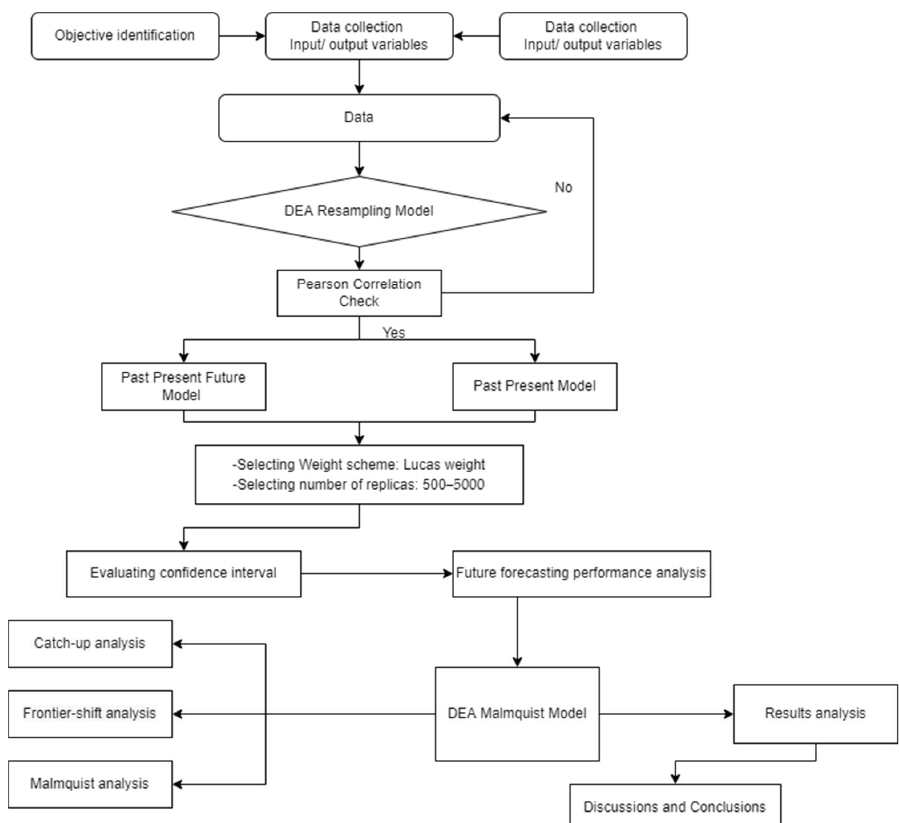
Figure 1. Research framework.